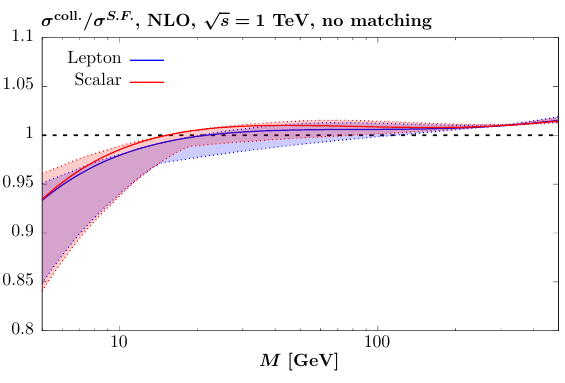
Figure 2 . As in (cid:12)gure 1 (right), but excluding the ‘matching’ term in